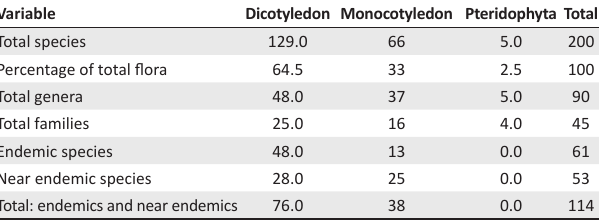
TABLE 2: Comparison of the 15 best represented angiosperm families by number of species, including endemics and near endemics, on inselbergs, a subset of the Drakensberg Alpine Centre, together with their representation within the broader Drakensberg Alpine Centre. Families ordered by rank of total species on inselbergs (rank within DAC) 1